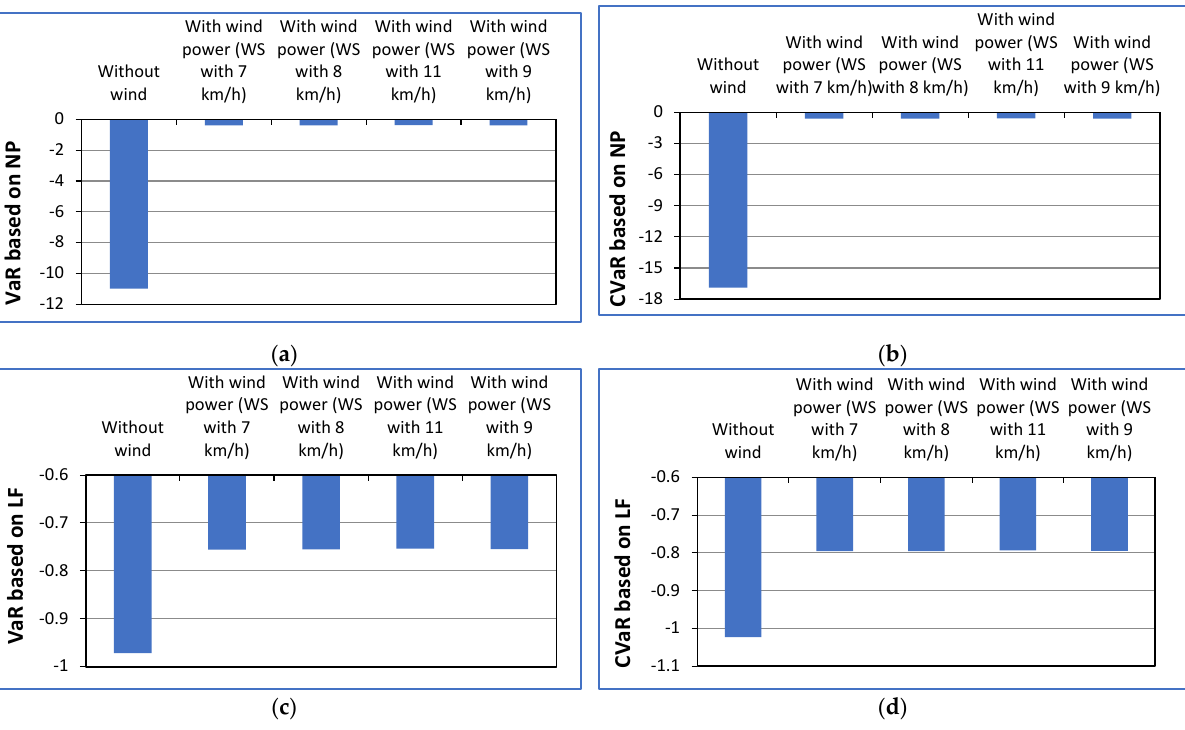
Figure 6. System Risk with Wind Power Integration (Mumbai @ Bus_14 (15%)). VaR based on NP ( a ), CvaR basd on NP ( b ), VaR based on LF ( c ), CvaR based on LF ( d ).